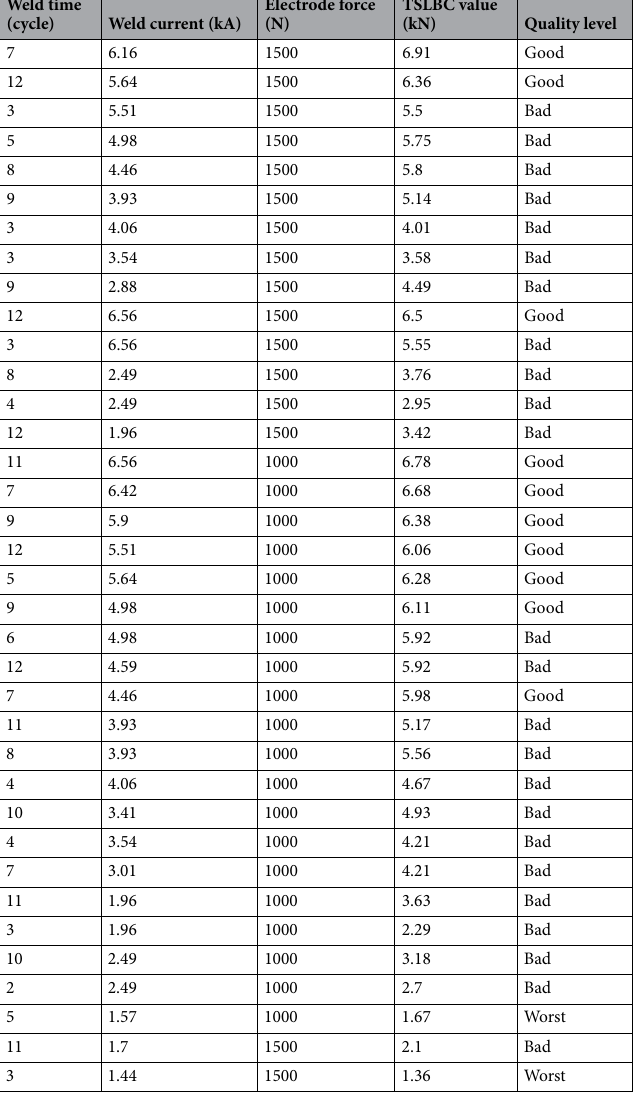
Table 3. Data Collection of RSW dataset.